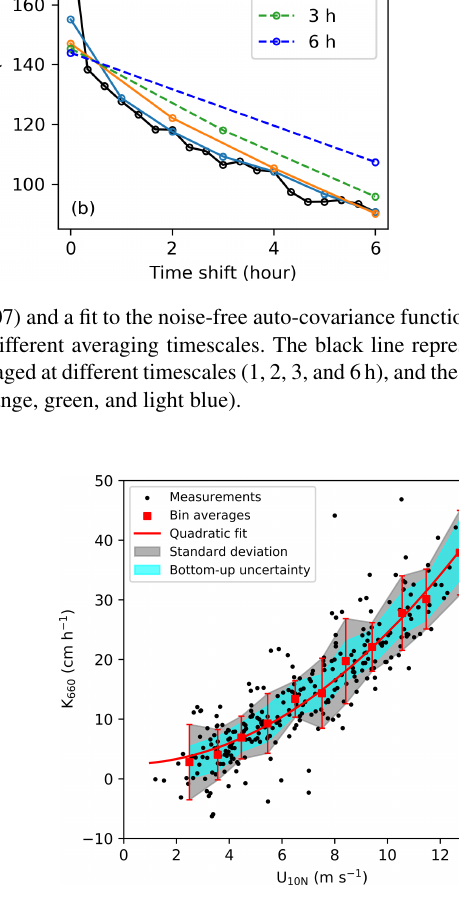
Figure 9. Gas transfer velocity ( K 660 ) measured on Arctic cruise JR18007 (hourly average, signal : noise ∼ 5) vs. 10m neutral wind speed ( U 10N ). Red squares represent 1ms − 1 bin aver- ages, with error bars representing 1 standard deviation (SD). The red curve represents a quadratic fit using the bin averages: + 2.46 ( R 2 = 0.76). The grey shaded area rep- K 660 = 0.22 U 2 10N resents the standard deviation calculated for each wind speed bin ( K 660 ± 1SD). The cyan region represents the upper and lower bounds in K 660 uncertainty computed from the EC flux uncertainty ( K 660 ± δK 660 ; see text for